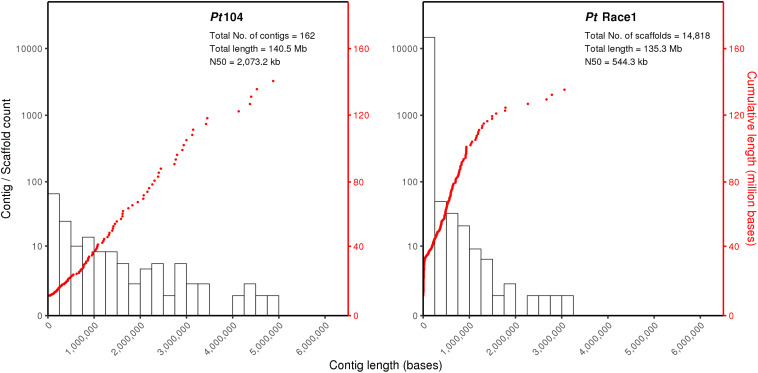
The Pt104 genome assembly with significantly reduced total contig number and improved N50 as compared to Pt race1 genome. The log10 counts of contigs within each size bin are shown by histograms with the left y-axis. Each dot represents a single contig of a given size corresponding to the x-axis. The cumulative sizes of contig lengths sorted from small to large are shown by the dots with the right y-axis. The number of contigs or scaffolds, total assembly size, and N50 of the assembly are also shown within each plot.